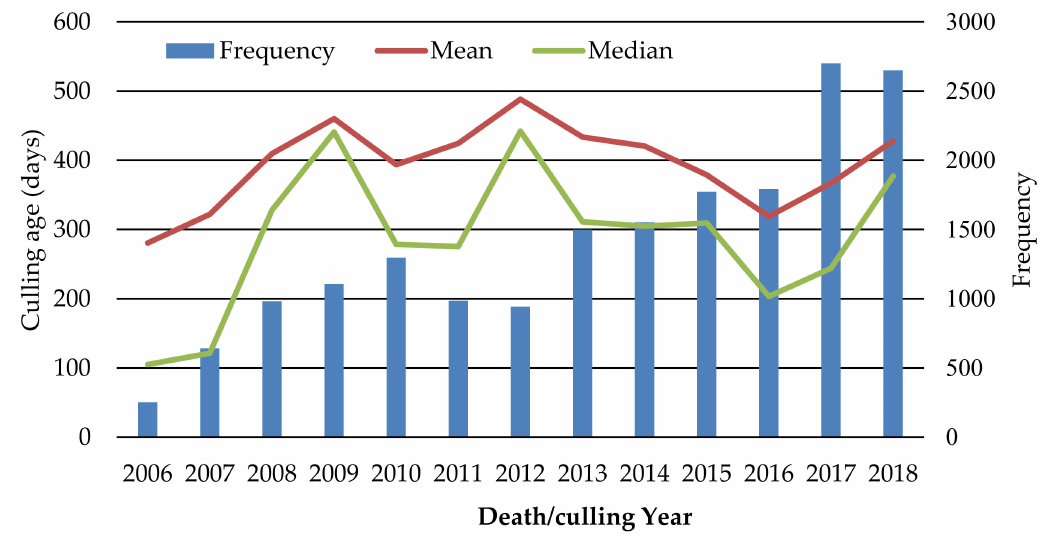
Figure 3. Average death / culling age (days) and number of dairy calves and replacement heifers in di ff erent death